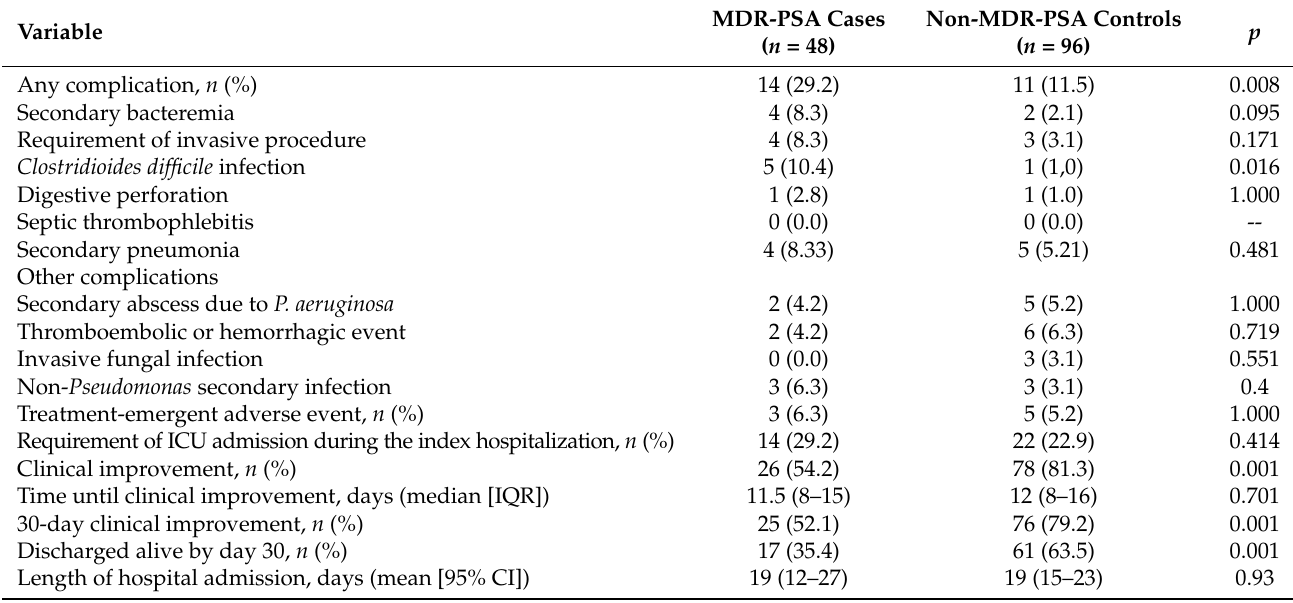
Table 4. Complications during the index hospitalization and outcomes in MDR-PSA cases and non-MDR-PSA